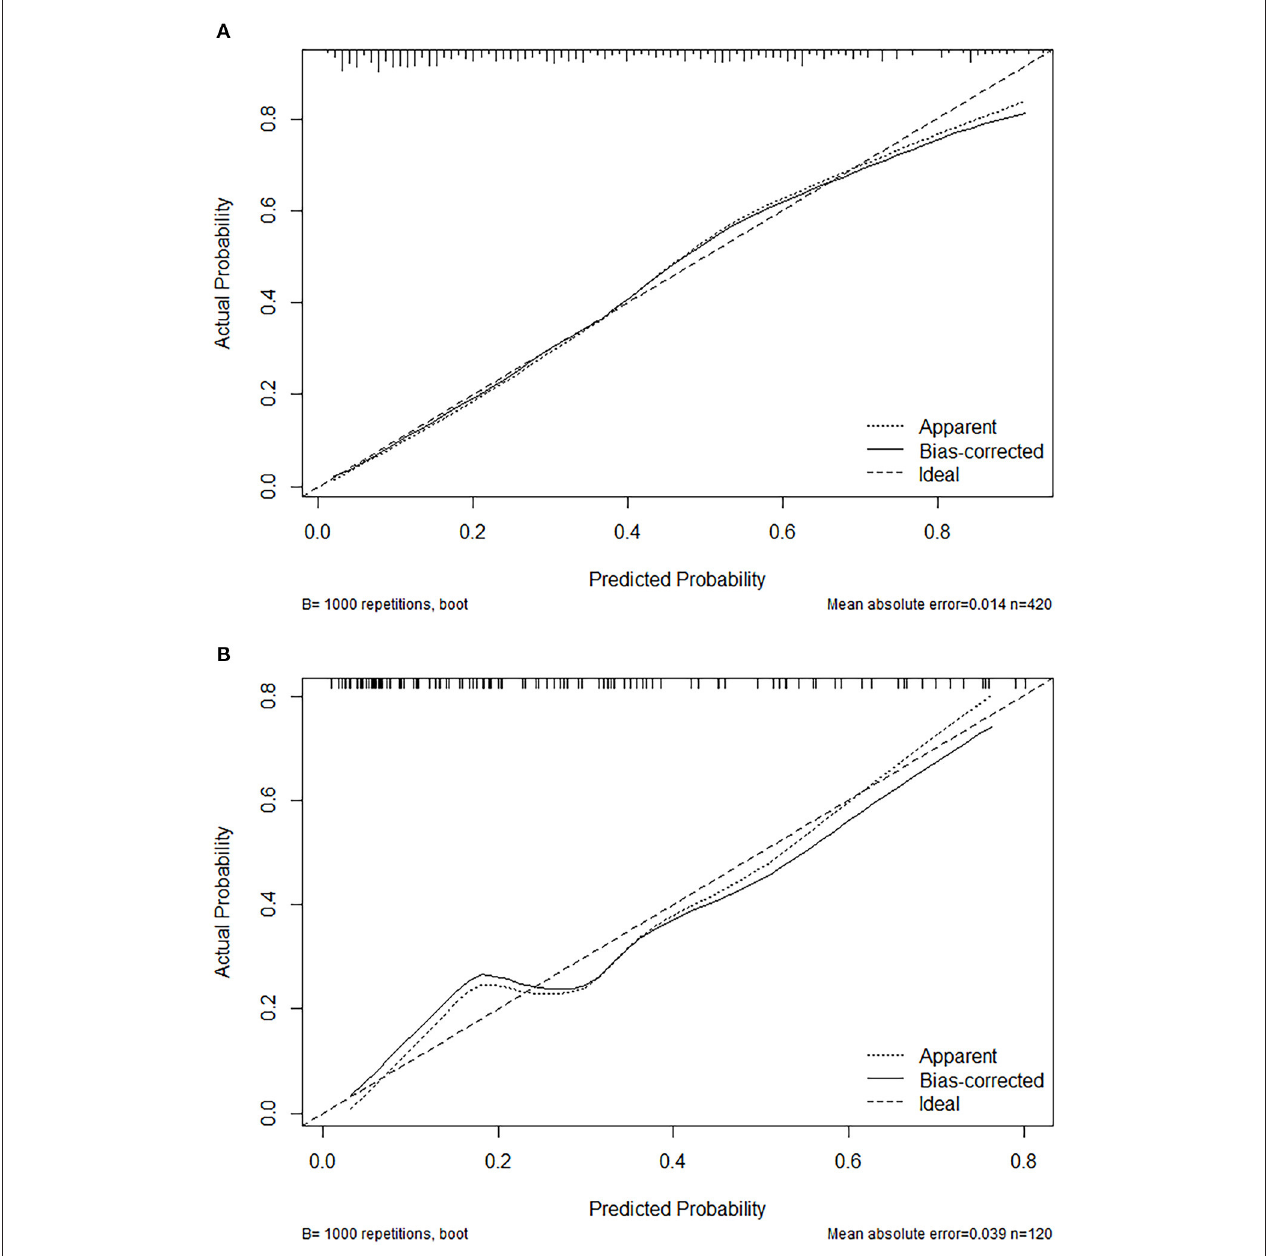
FIGURE 4 | Calibration plot of the nomogram in the primary cohort (A) and validation (B) cohort. Predictions generated from the model are plotted against actual patient outcomes. The 45-degree line represents the perfect model calibration. The dotted line (apparent) indicates calibration when the model is applied to each set, and the solid line (bias-corrected) indicates calibration when the model is applied to the bootstrap set.